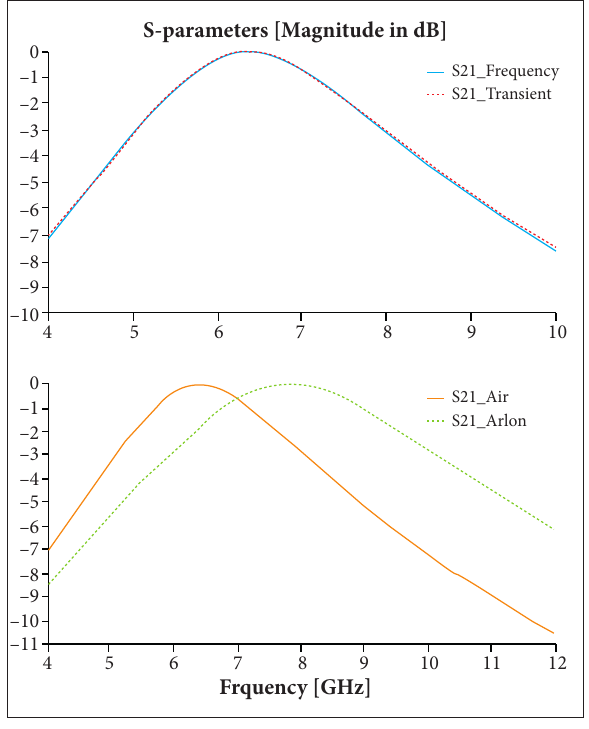
Figure 2. (a) Simulated (transient and frequency solvers) FSS unit cell — the S21 transmittance is shown; (b) Comparison of the transmittance response with Arlon product and air as substrates.